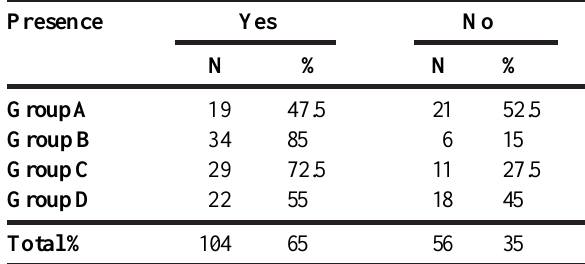
TABLE 7 - Histopathological evaluation of surgical wound.